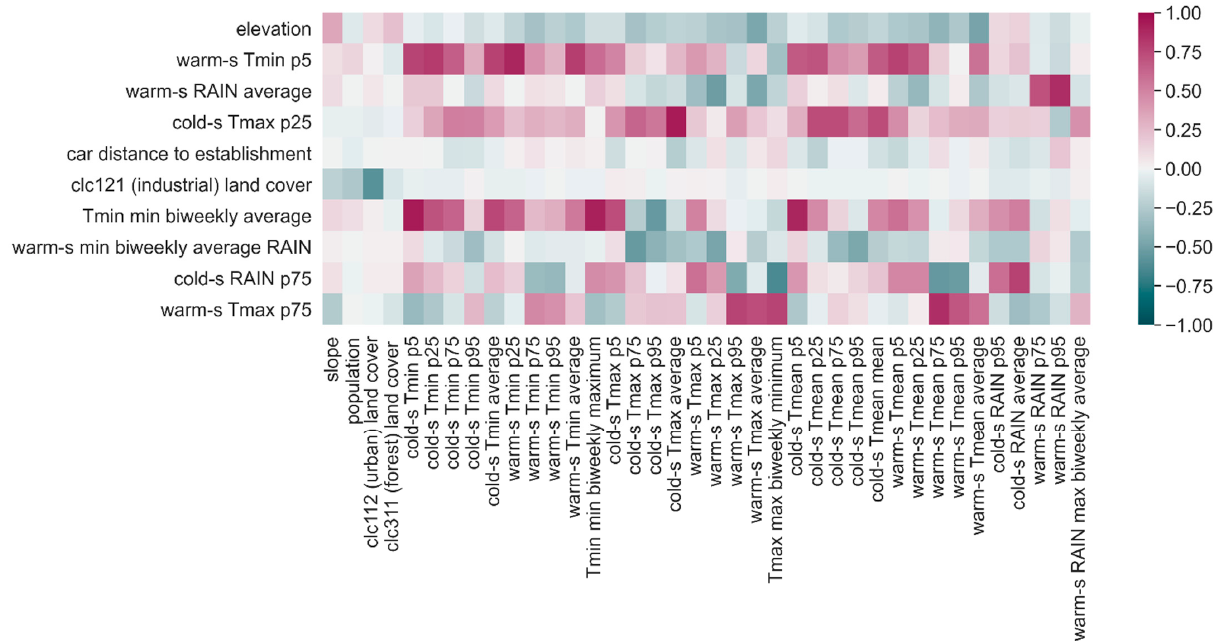
Figure A2. Heatmap of the Spearman’s rank correlation coefficient between the selected predictors and the other predictors (only variables with absolute correlation coefficient larger than 0.2 for at least one selected predictor are included).